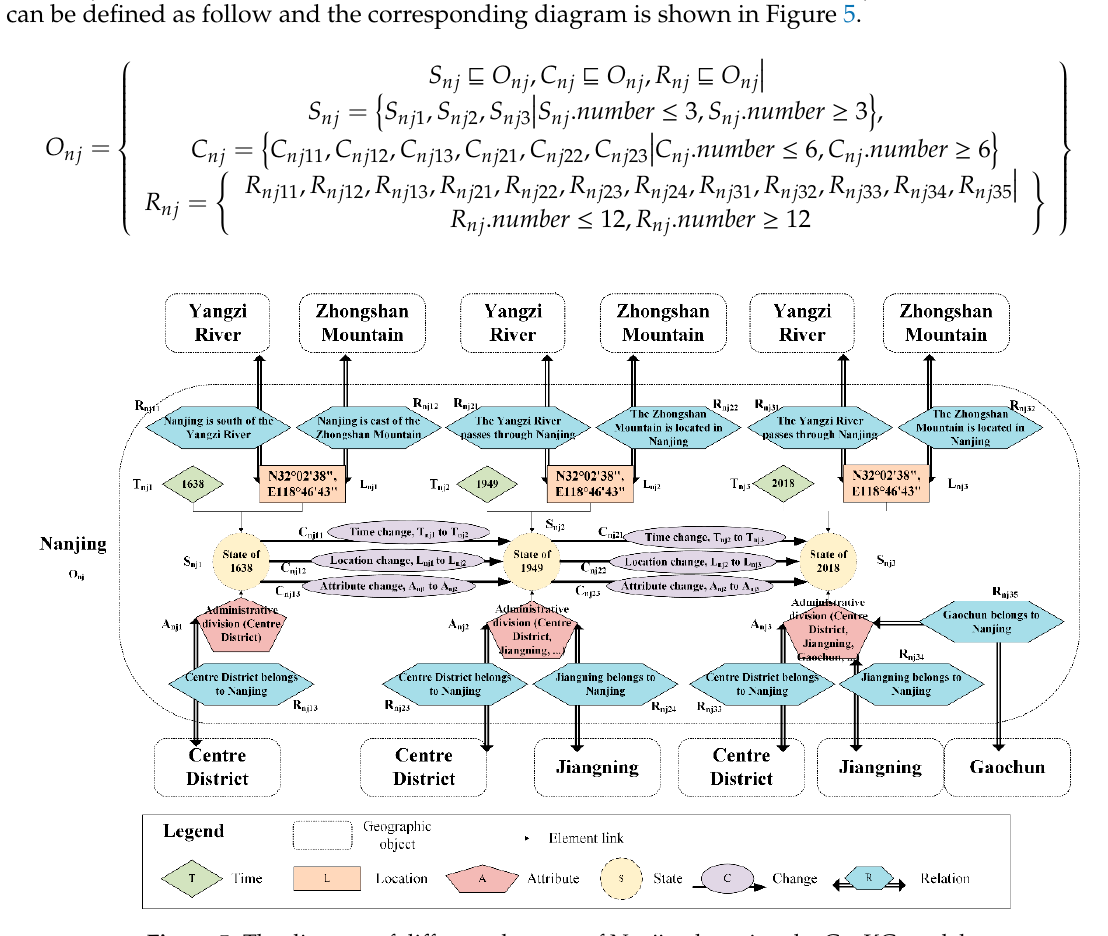
Figure 5. The diagram of different elements of Nanjing by using the GeoKG model.